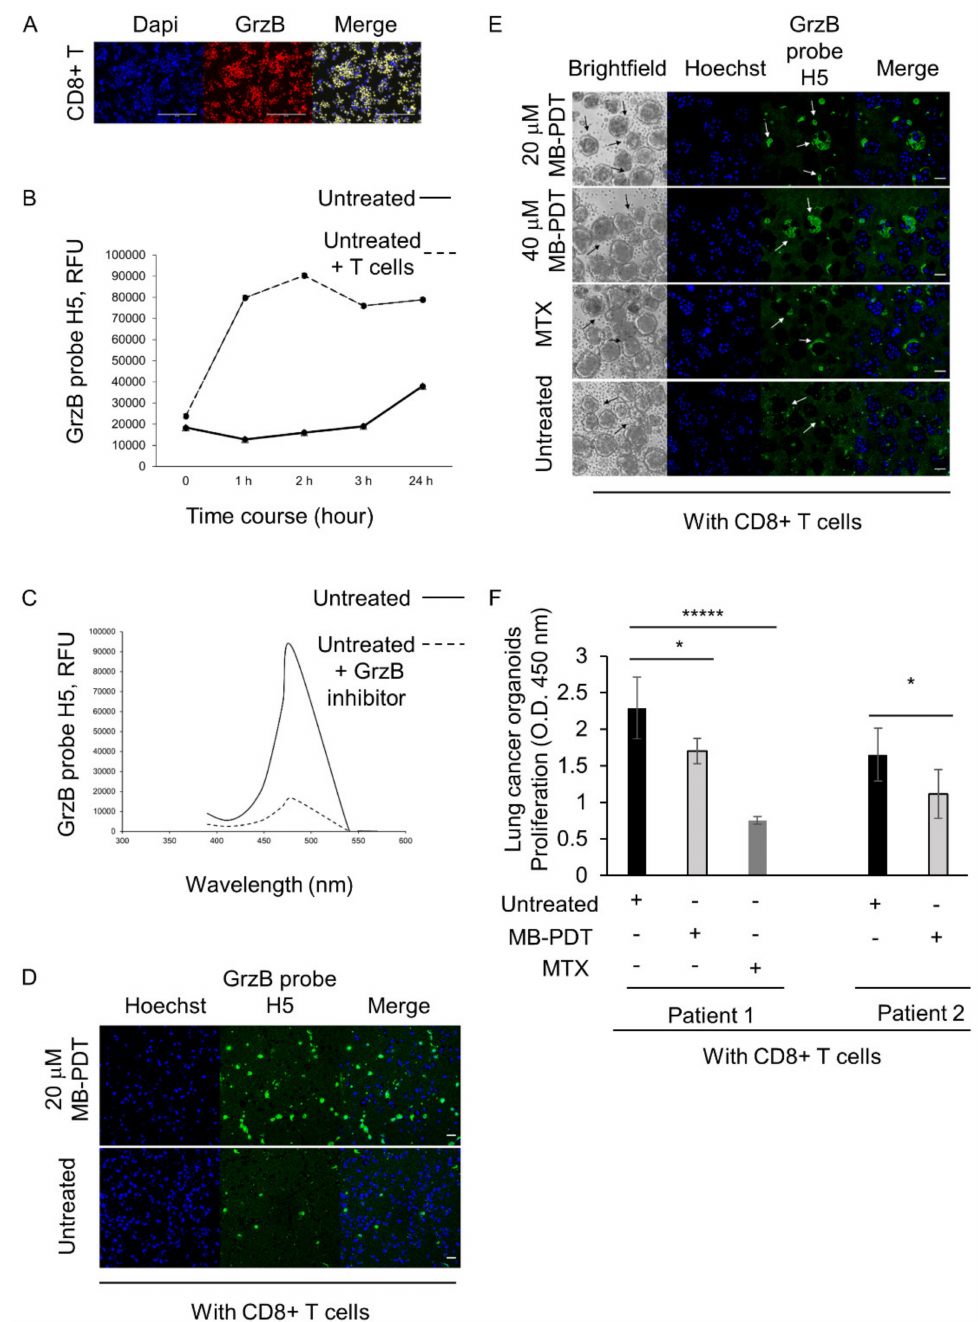
Figure 5. Grz B probe H5 detects the cytotoxic activity of CD8+ T cells in lung cancer cells and organoids co-culture killing assay. ( A ) Representative immunofluorescence images of endogenous Granzyme B in activated CD8+ T cells before adding them into a co-culture with cancer cells. SP8 confocal microscope. Scale bar: 200 µ m. Images were processed/analysed with ImageJ. ( B ) The time course of GrzB probe H5 (5 µ M) activity followed incubation with activated CD8+ T cells, effectors, and target H1299 cells at a ratio of 6:1. Representative image, n = 5 (per condition). The comparison of fluorescence between different samples was obtained by a Synergy H1 Hybrid